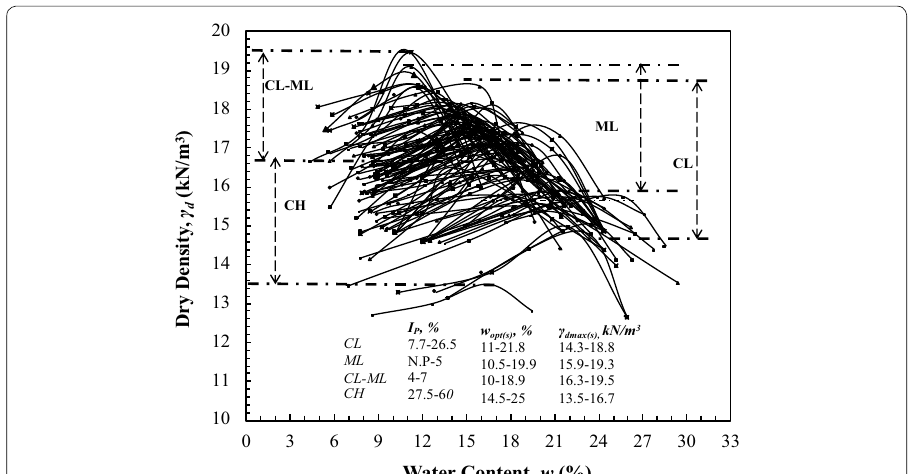
Fig. 4 Standard compaction curves of soil samples